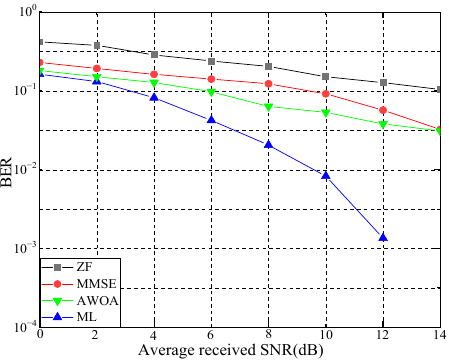
Figure 9. BER in 8*8 MI-MIMO.